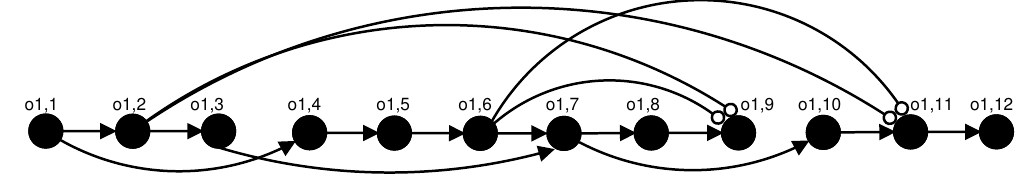
Figure 4. Subgraph representing the code from Figure 3.